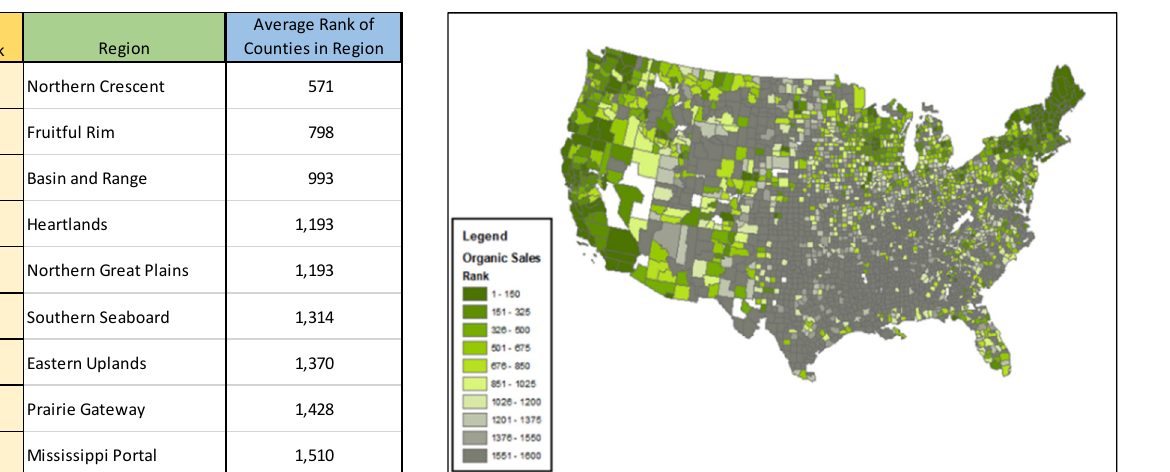
Map 8. Organic Sales Rank,